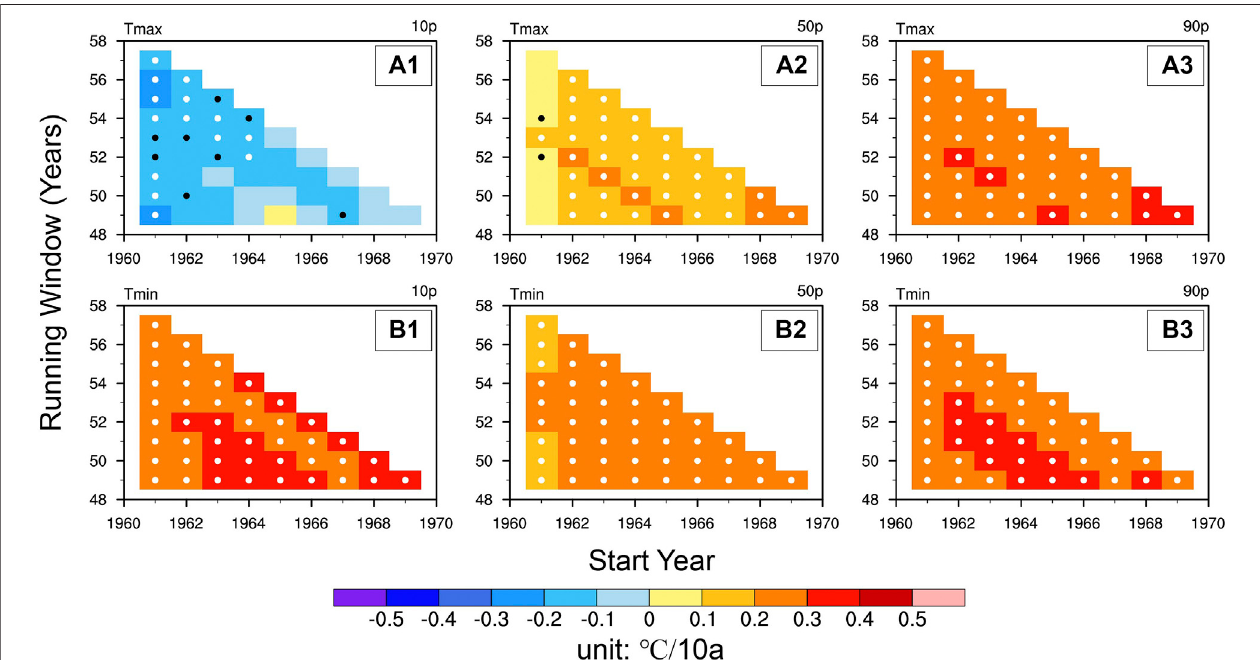
FIGURE 2 | Running window quantile trends in the 10th (column 1), 50th (column 2), and 90th (column 3) percentiles of Tmax [row (A) ] and Tmin [row (B) ] at the point (120 ° E, 31 ° N) within the YRB region, unit: ° C/10a. The x -axis represents the start year of the analysis period, while the y -axis represents the length of the analysis period. White and black dots represent trends that are statistically signi fi cant at 99% and 95% con fi dence levels, respectively.